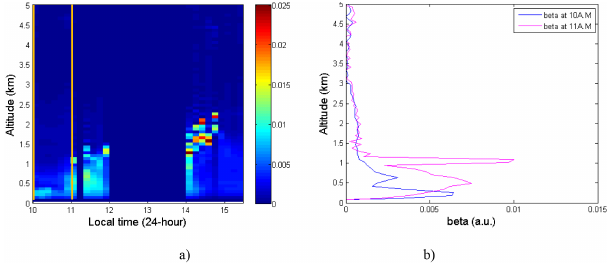
Figure 6. (a) Profiles of the aerosol backscatter coefficients (km − 1 sr − 1 ) recorded on 12 July 2013. No data were acquired from 12 to 2p.m. The brown lines represent the moment of acquisition of sun photometer; (b) profiles of the aerosol backscatter coefficient (beta) obtained from 10 to 11a.m. for the brown lines in (a)